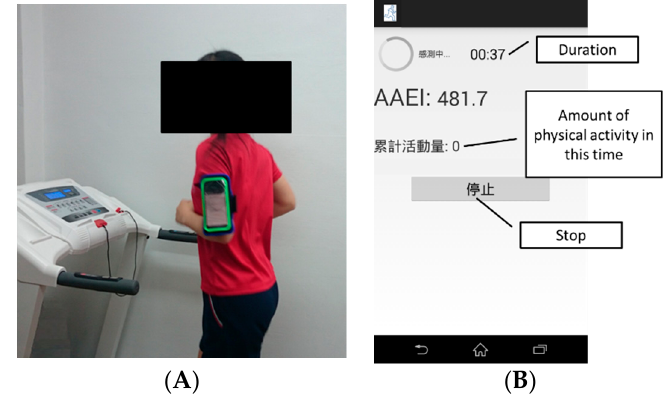
Figure 5. Data collection for activity level estimation. ( A ) Participant wearing smartphone on the left upper arm and performing exercise on a treadmill; ( B ) Smartphone screenshot during exercise measurement.